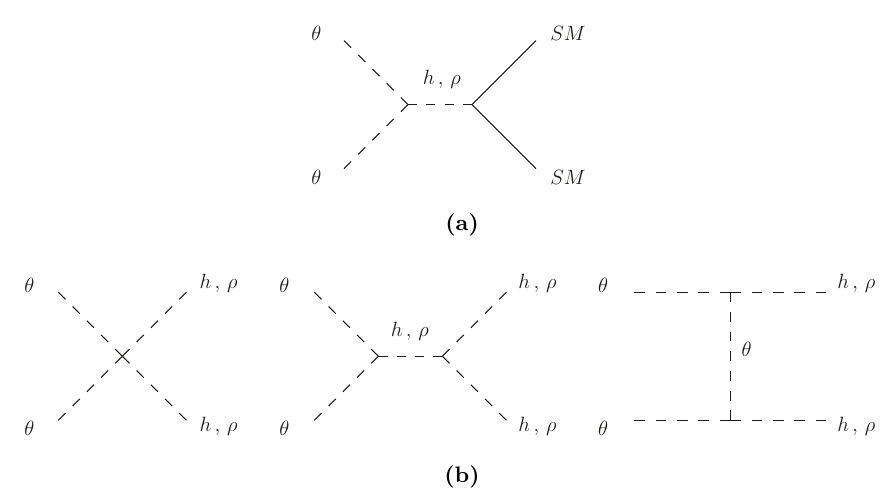
Figure 1. Feynman diagrams of the possible DM annihilation channels. (a) DM annihilations into SM states mediated by the Higgs boson h and the scalar ρ . (b) DM annihilations into h, ρ for the case of forbidden and secluded